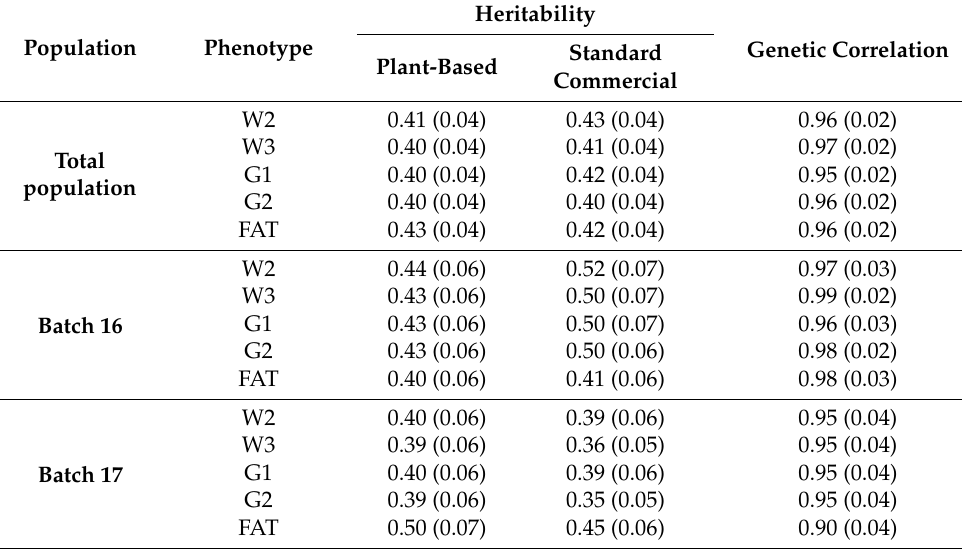
Table 6. Bivariate heritability and genetic correlation under different diets.